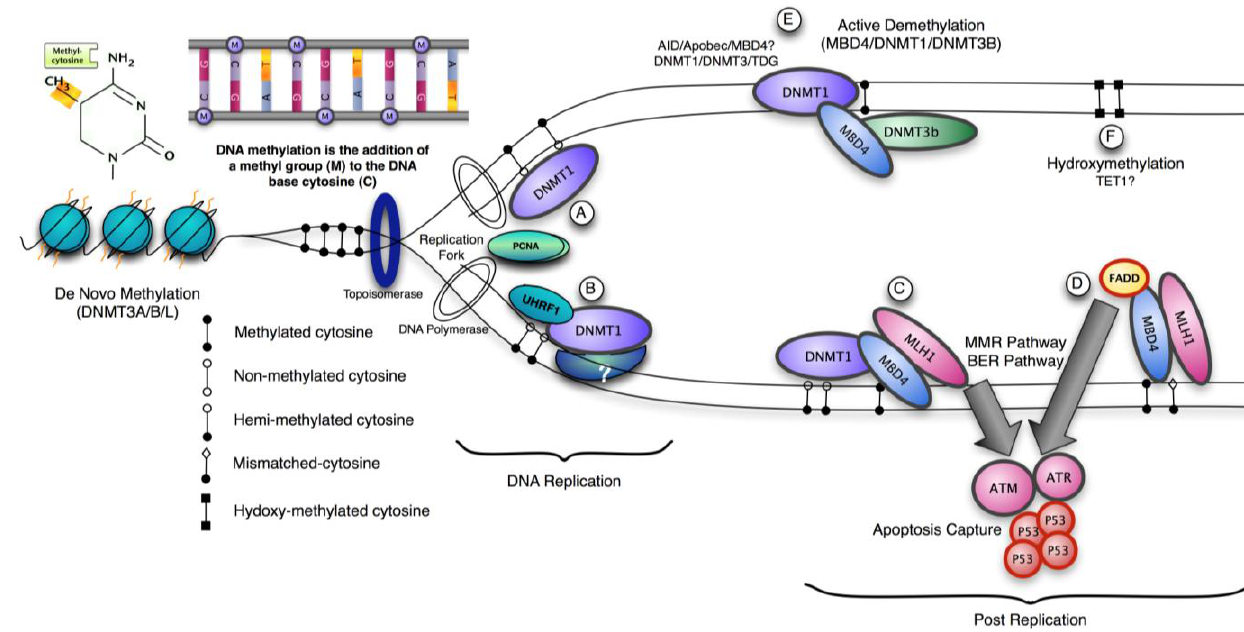
Figure 1. Maintainance of DNA Methylation. (A-B)The preferential substrate for the maintenance cytosine methyltransferase, DNMT1, is hemi-methylated CpG sites resulting from newly synthesized DNA in somatic cells. DNMT1 is present at the replication fork, and functions with the help of partner proteins including UHRF and PCNA . (C) Post- replication, DNMT1 and a methyl-CpG binding protein MBD4 can be localized together at DNA damage sites and may be part of cellular pathway response that activates apoptosis. MBD4 interacts directly with both DNMT1 and MLH1 leading to recruitment of all three at DNA damage sites. (D) MBD4 has also been shown to recruit Fas-associated death domain protein (FADD), which bridges death receptors with initiator caspases. FADD may also be an apoptotic effector via MBD4. (E) Several active DNA demethylation models have been proposed. MBD4 was reported to execute active DNA demethylation at the CYP27B1 promoter in response to PTH (Parathyroid Hormone) signaling. Similarly TDG (Thymine DNA glycosylase) can also interact with Dnmt3A and Dnmt3B and function as 5meC glycosylase activity against hemi-methylated DNA with the same weak excision activity as MBD4. In zebrafish embryos Aid, Mbd4 and the DNA repair protein Gadd45a may cooperate to induce demethylation. Thymine glycosylases such as TDG and MBD4 may function on deamination of 5-methyl-cytosine by repairing the resulting mismatch. (F) TET1 is capable of acting on both fully methylated and hemi-methylated DNA, producing 5-hydroxymethylcytosine (5hmC) in DNA, which may also act in signaling pathways associated with turnover and maintenance of the